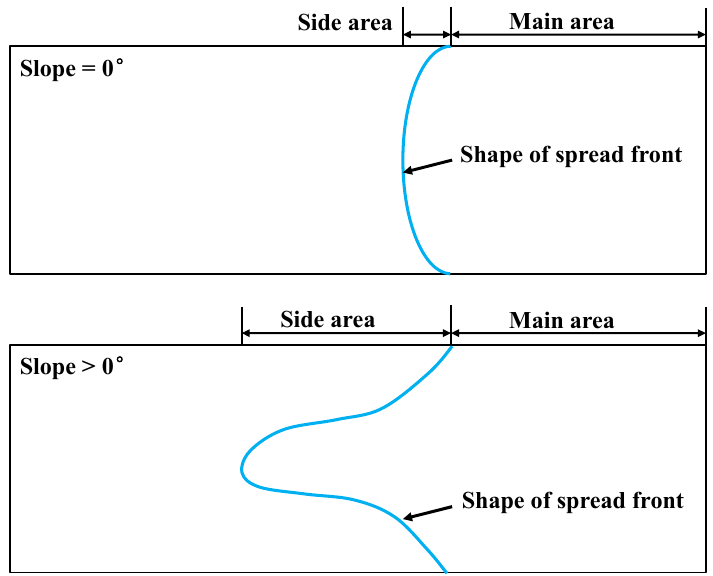
Figure 4. Shape of the spread surface for different slopes.